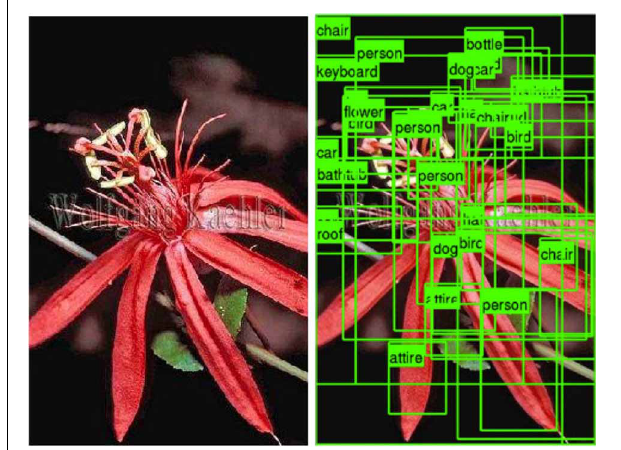
FIGURE 1 | Detection results for 120 common object categories.